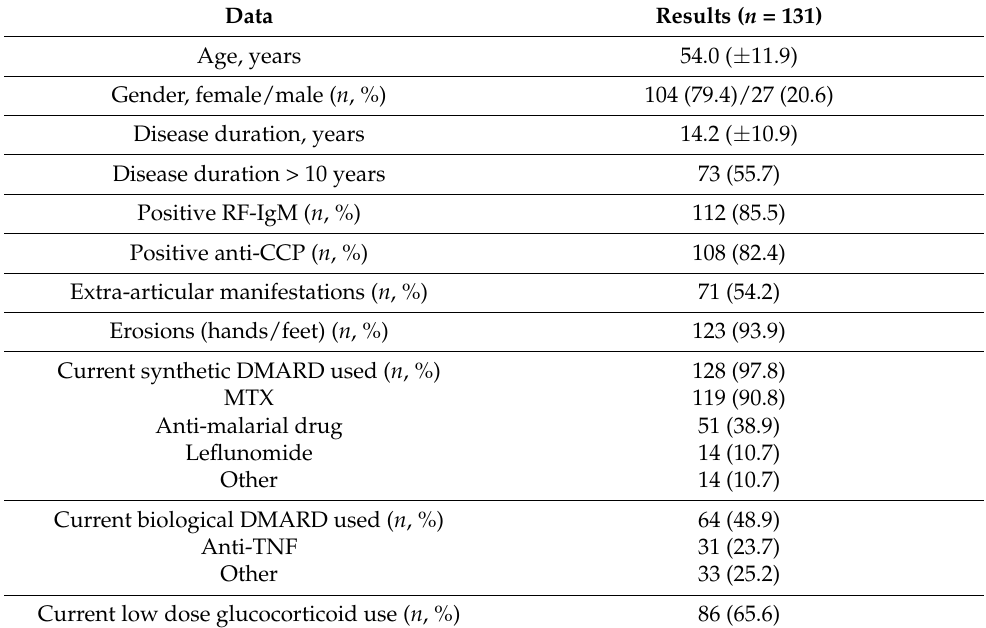
Table 1. Characteristics of patients with